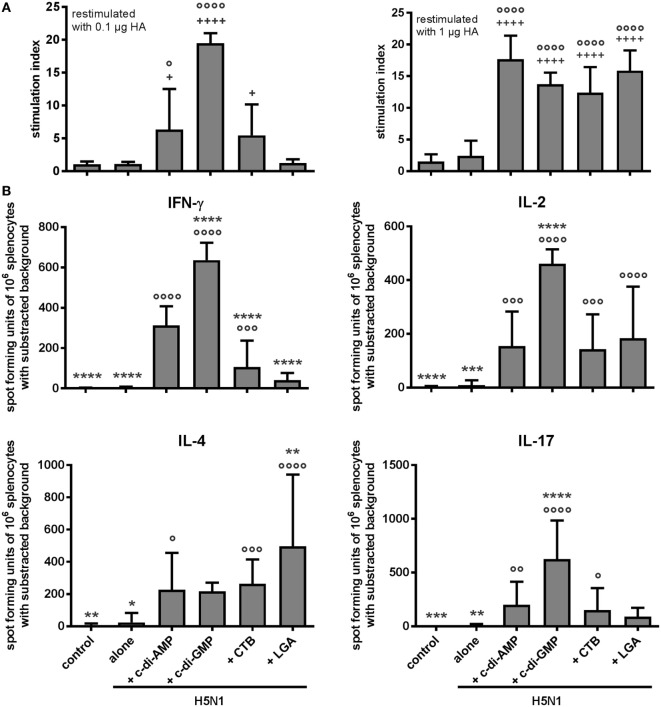
Cellular response. Groups of 3–5 BALB/c mice were immunized intranasally with PBS (control) or with two doses (21 days apart) of H5N1 virosomes (7.5 µg hemagglutinin), alone or adjuvanted with cyclic di-adenosine monophosphate (c-di-AMP) (5 µg), c-di-GMP (5 µg), cholera toxin subunit B (CTB) (10 µg), or last (or third) generation adjuvant (LGA) (7.5 µg). At 21 days after the second immunization, spleen cells were harvested, pooled, and restimulated with homologous H5N1 virosomes. (A) Proliferation. The proliferative response was measured by incorporation of 3H-thymidine (counts per minute, cpm). The stimulation index (cpm of restimulated sample vs. cpm of unstimulated sample) is shown from quadruplicates of n = 3 (PBS, alone), n = 2 (c-di-AMP, CTB), or n = 1 (c-di-GMP, LGA) independent experiments, as mean + SD. Statistically significant differences were measured by one-way ANOVA with Tukey’s post hoc test; differences from the negative control or antigen alone group are shown by plus signs or circles, respectively (+/°p < 0.05, ++/°°p < 0.01, +++/°°°p < 0.001, ++++/°°°°p < 0.0001). (B) Cytokine production. The number of cytokine-producing cells was determined by ELISpot. Results are presented as spot-forming units of 106 restimulated cells minus the background values from unstimulated cells. The mean + SD are shown from triplicates in two cell concentrations of n = 4 (PBS, alone), n = 3 (c-di-AMP, CTB), n = 2 (LGA), or n = 1 (c-di-GMP) independent experiments. Statistically significant differences were measured by one-way ANOVA with Tukey’s post hoc test; differences from the c-di-AMP or antigen alone group are shown by asterisks or circles, respectively (*/°p < 0.05, **/°°p < 0.01, ***/°°°p < 0.001, ****/°°°°p < 0.0001).